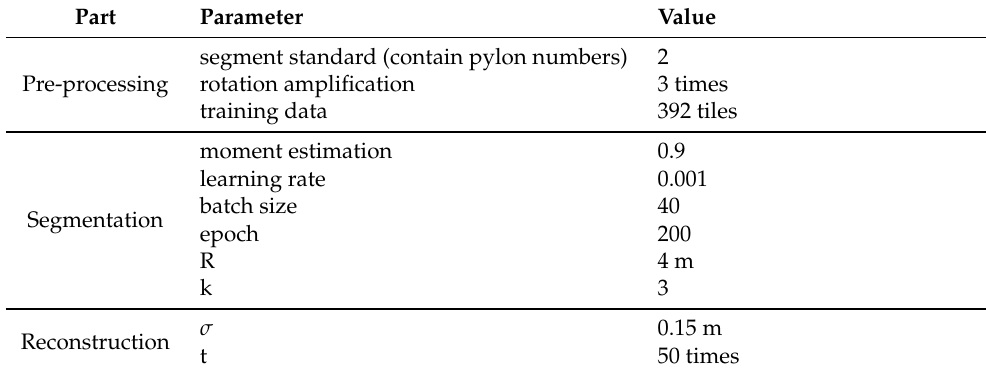
Table 4. Parameter settings.